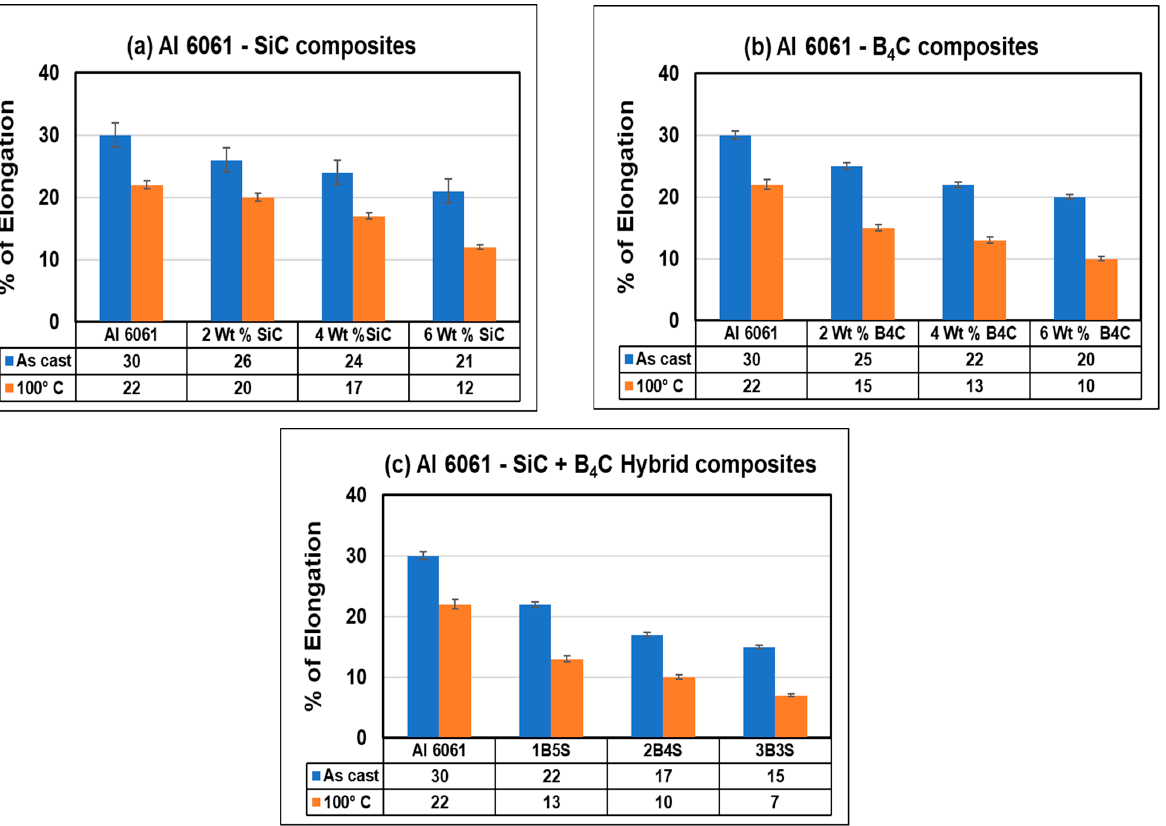
Figure 8. Effect of SiC and B 4 C on percentage elongation of ( a ) Al6061-SiC, ( b ) Al6061-B 4 C, and ( c ) Al6061-SiC + B4C composites.